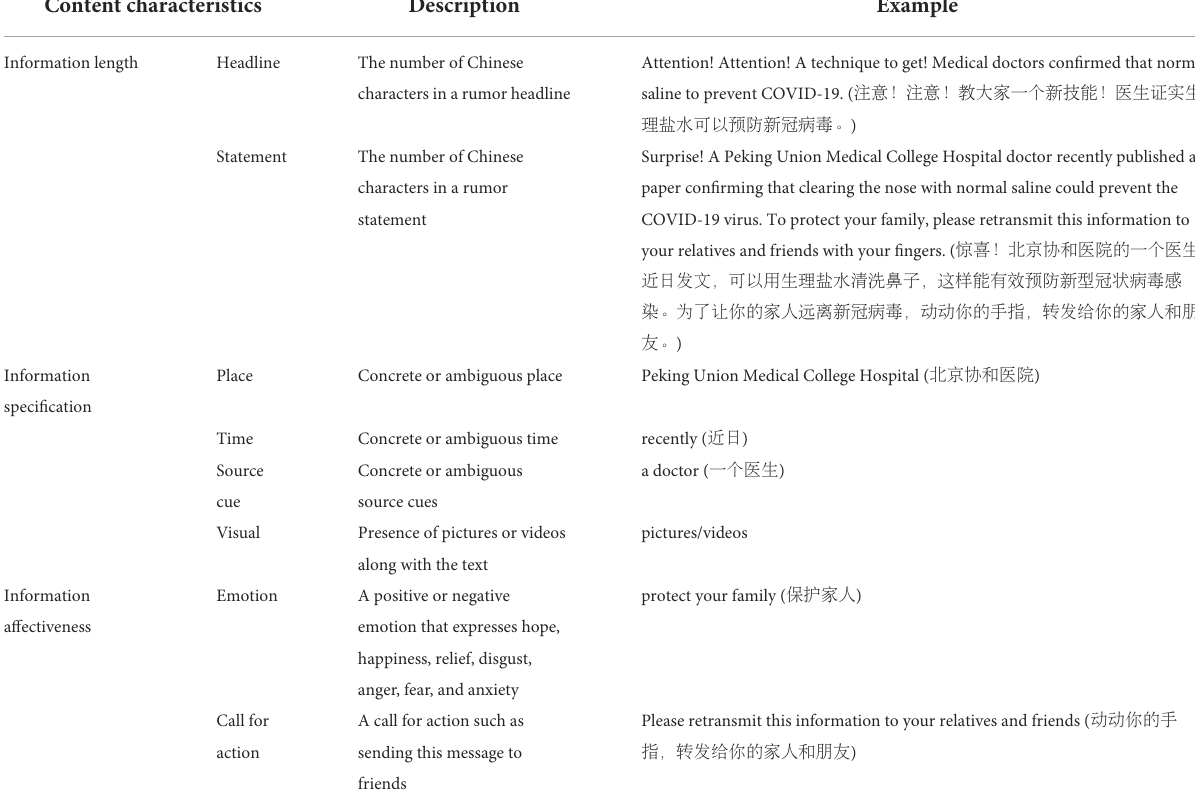
TABLE 1 Examples of COVID-19 rumors and their content characteristics.